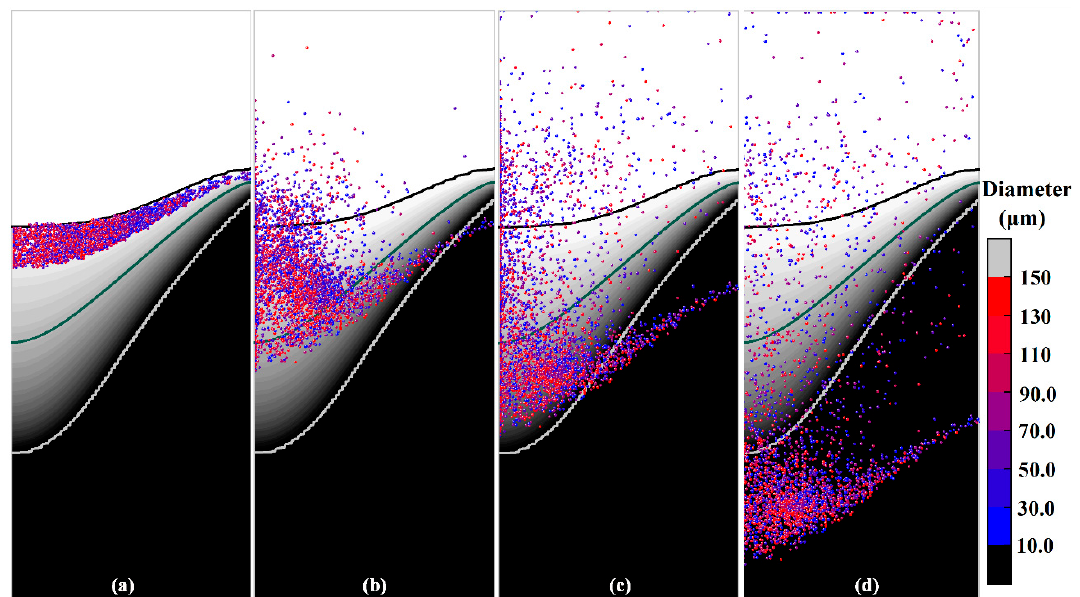
Figure 10. Simulated distribution of the grains with different diameters at different calculation times